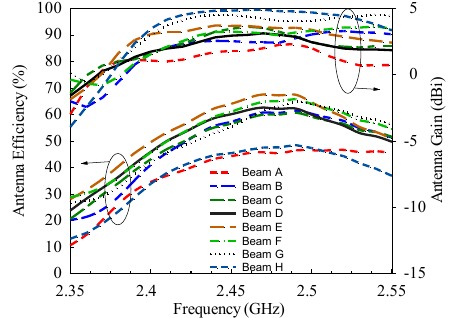
Figure 17: Simulated and measured radiation patterns of beams A, C, and E.